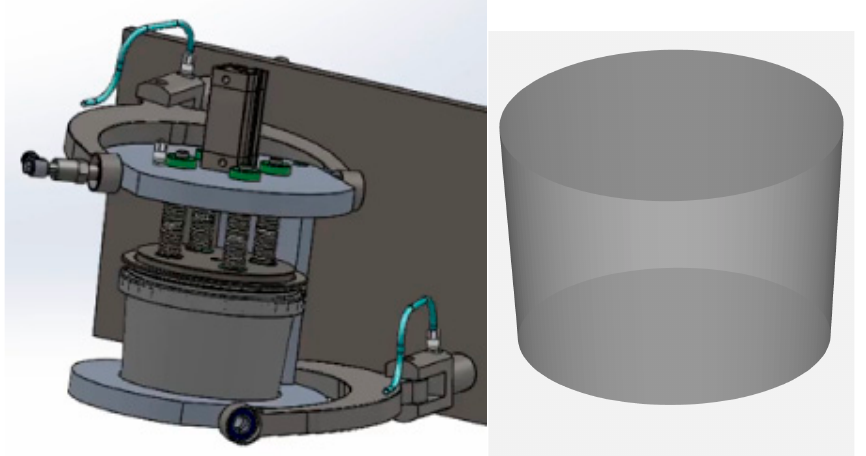
Figure 1. Image of the Turbula© mixer ( left ) and the geometry of the canister CFD geometry model ( right ). Note the canister location in the Turbula© mixer between the two plates of the fixation system.